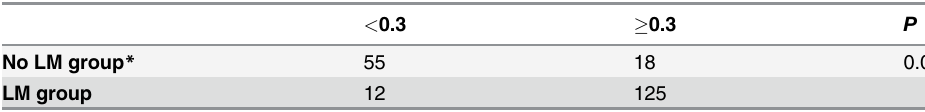
Table 7. The discriminant value of validation